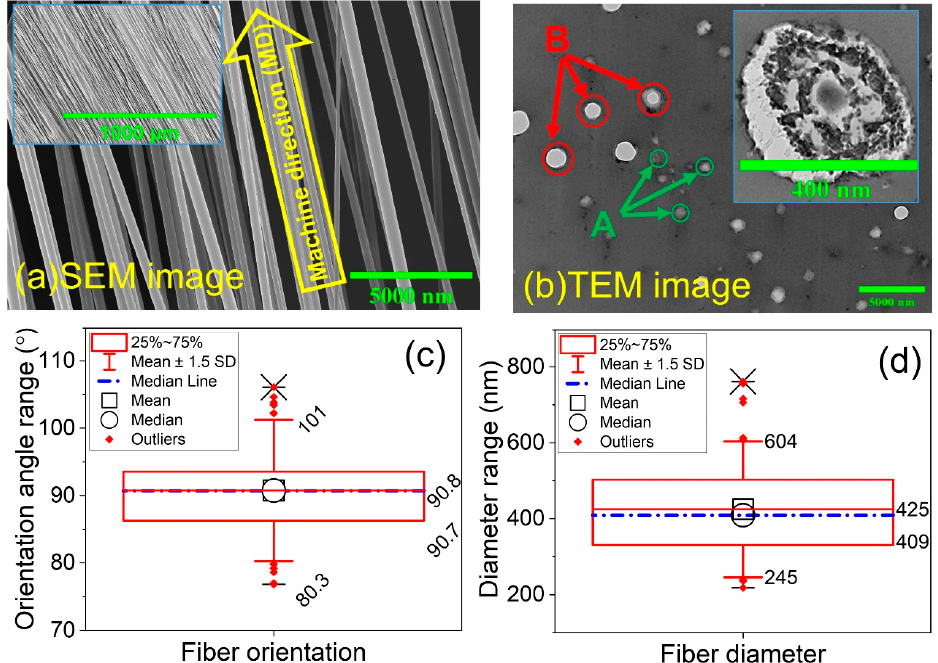
Figure 1. ( a ) shows the SEM images of aligned fibers having inset with lower magnification. ( b ) shows a cross-sectional TEM image of PLA-PANi:CSA fibers with φ PANi ≈ 7% concentration of filler; A: PLA-PANi:CSA fibers; B: artifacts from sample preparation. Inset shows a cross-sectional image of a single fiber. ( c , d ) show the directionality and diameter analysis with box plot analyses, respec- tively. The box outline is the interquartile range, the square and circle inside the box are the mean and median data points, the lines inside the box (red line and blue dash-dotted line) are the mean and median data locations, and the whiskers display the upper inner and lower inner fence values. Above and below the whiskers: ( − ) maximum/minimum data point and ( × ) 99th percentile. The general effective media (GEM) equations (Equations (1a) and (1b) presented by McLachlan) [29] were used to determine the critical volume fraction/percolation threshold ( φ c ) of CNBs.